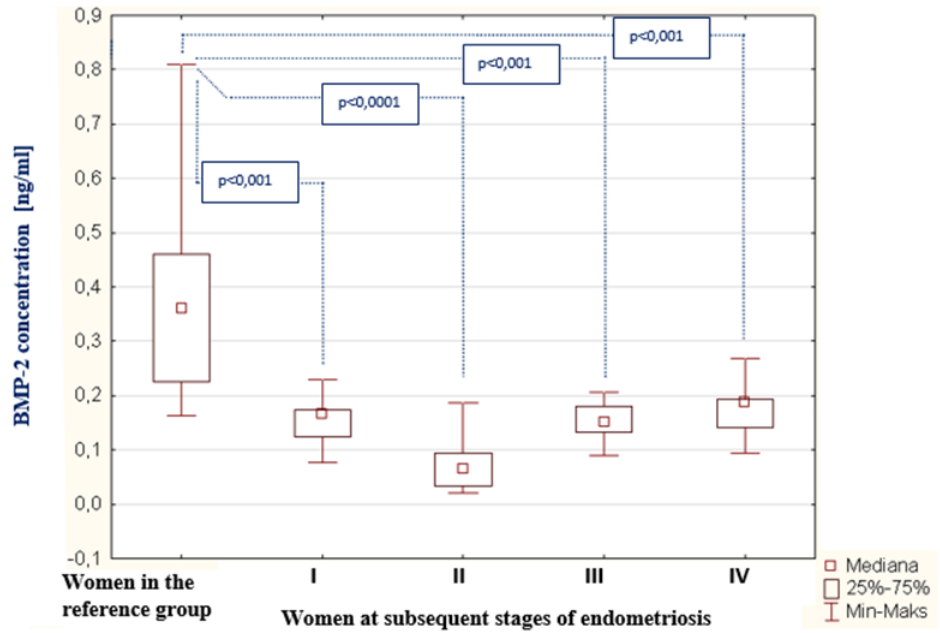
Figure 3. BMP-2 concentration in the peritoneal fluid of women at subsequent stages of endometriosis and women in the reference